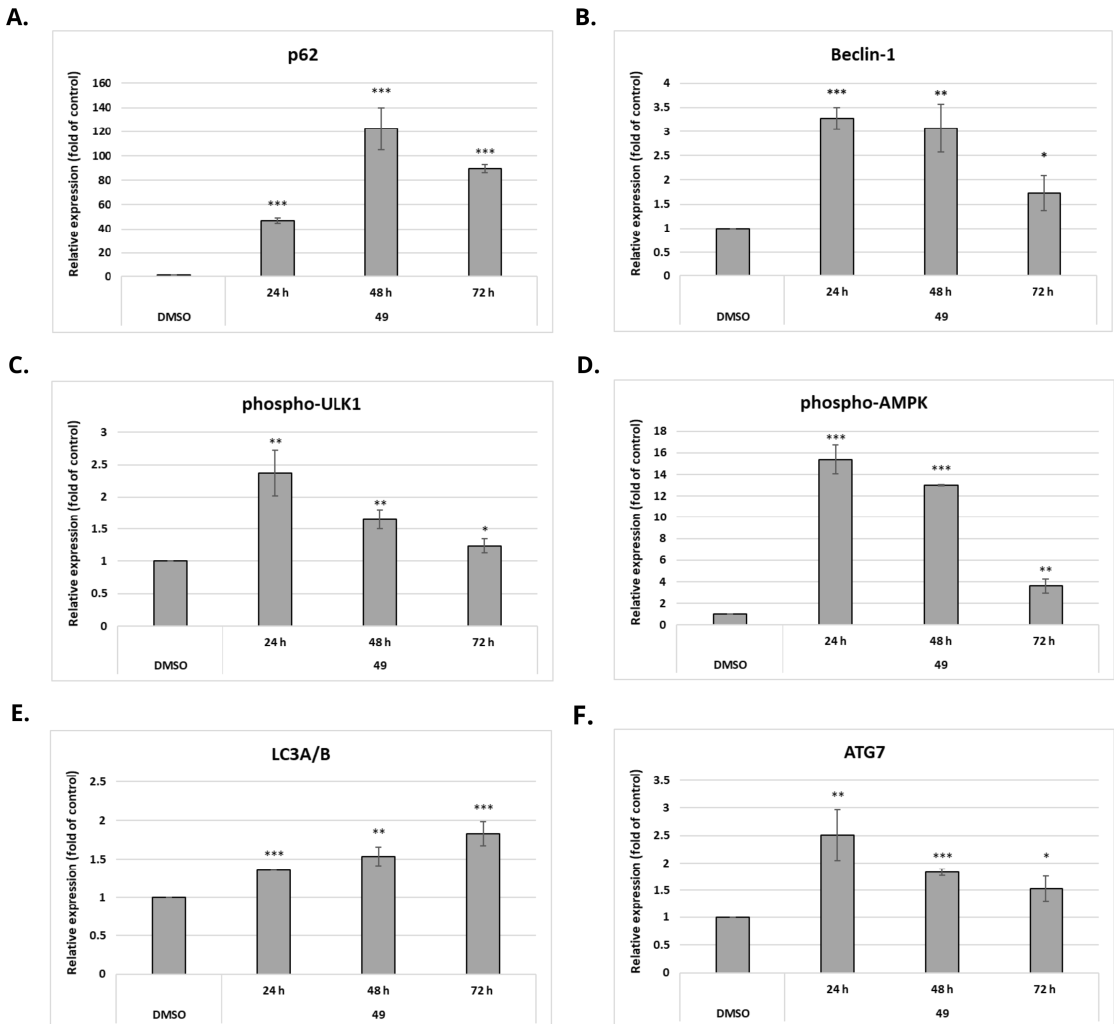
Figure 5. Densitometry analyses ( A – F ) of autophagy-related proteins after treatment with compound 49 for 24, 48, and 72 h. Statistical significance: * p < 0.05, ** p < 0.01, *** p < 0.001 vs. DMSO.